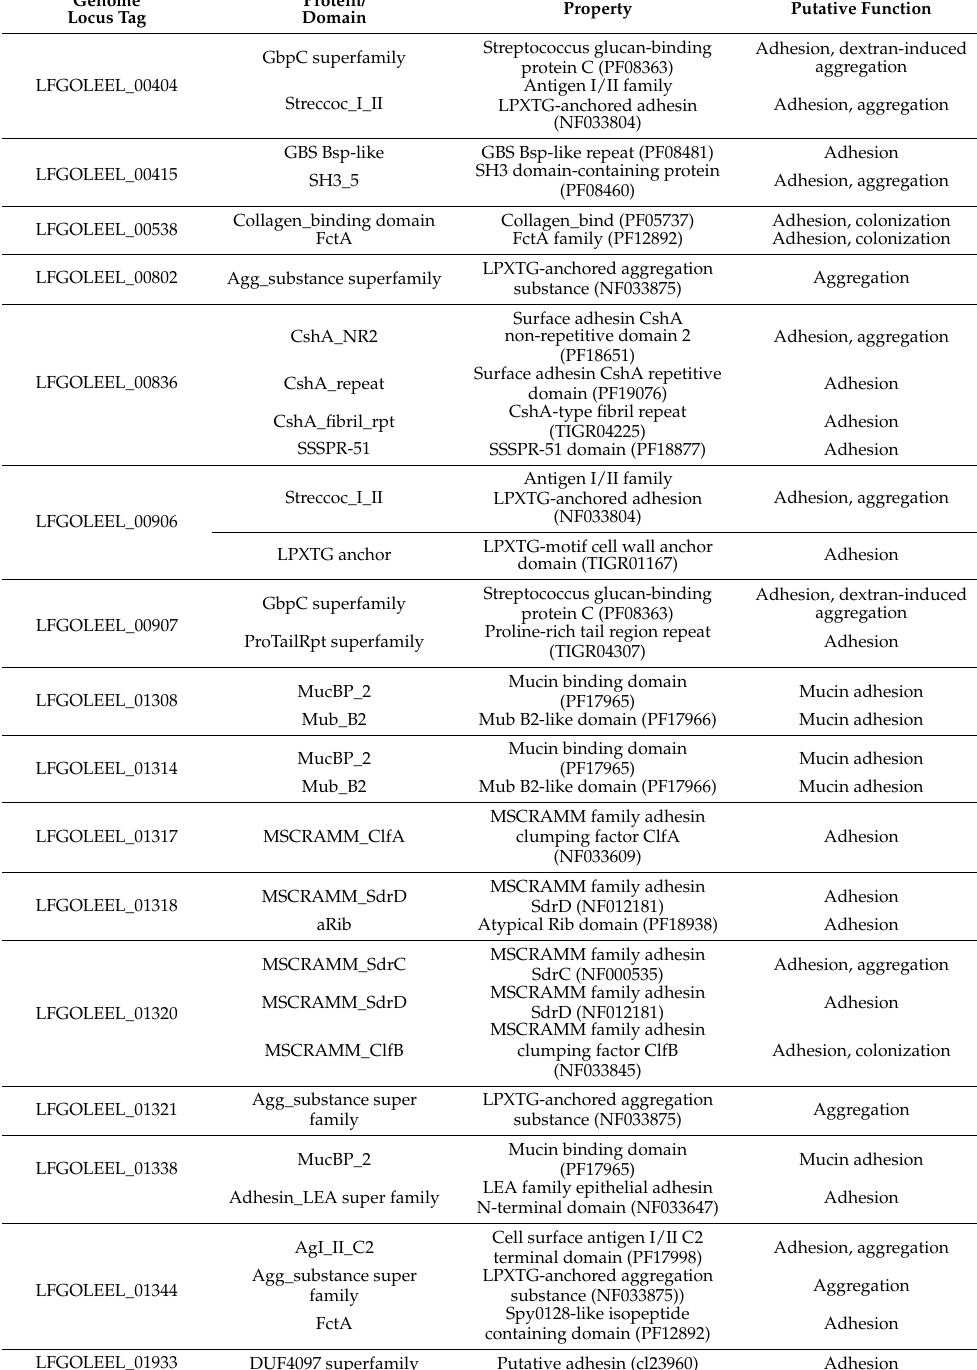
Table 3. Putative proteins involved in the aggregation and adhesion of S. salivarius 24SMBc. Genome Locus